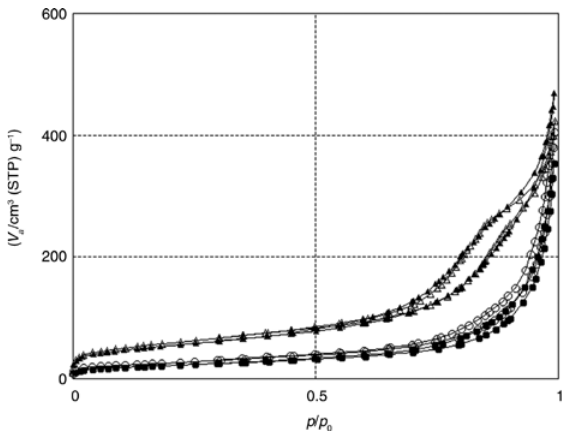
adsorptione/desorption isotherms of materials B. Figure 5: N 2